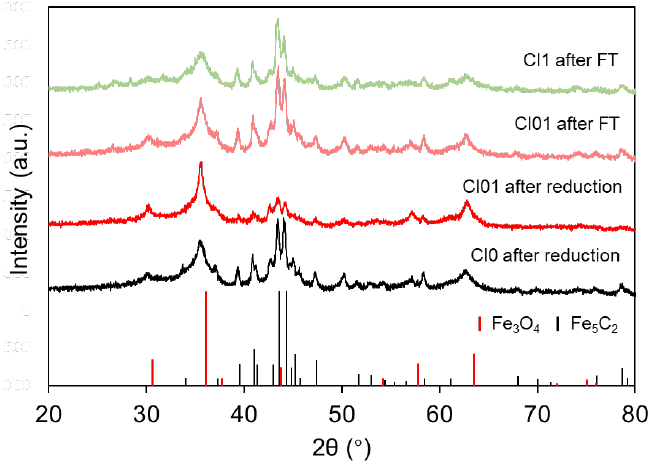
Figure 4. XRD patterns of Cl0, Cl01, and Cl1 catalysts after reduction and Fischer–Tropsch synthesis reaction.